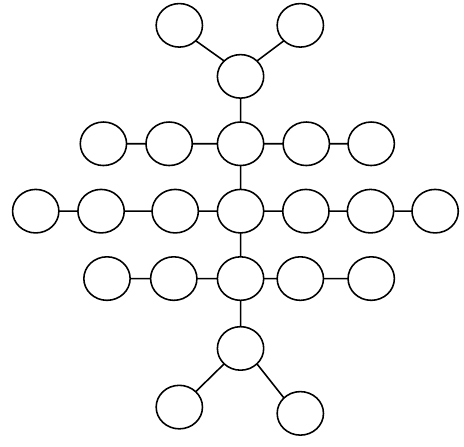
Figure 6. Millipede tree, M 5